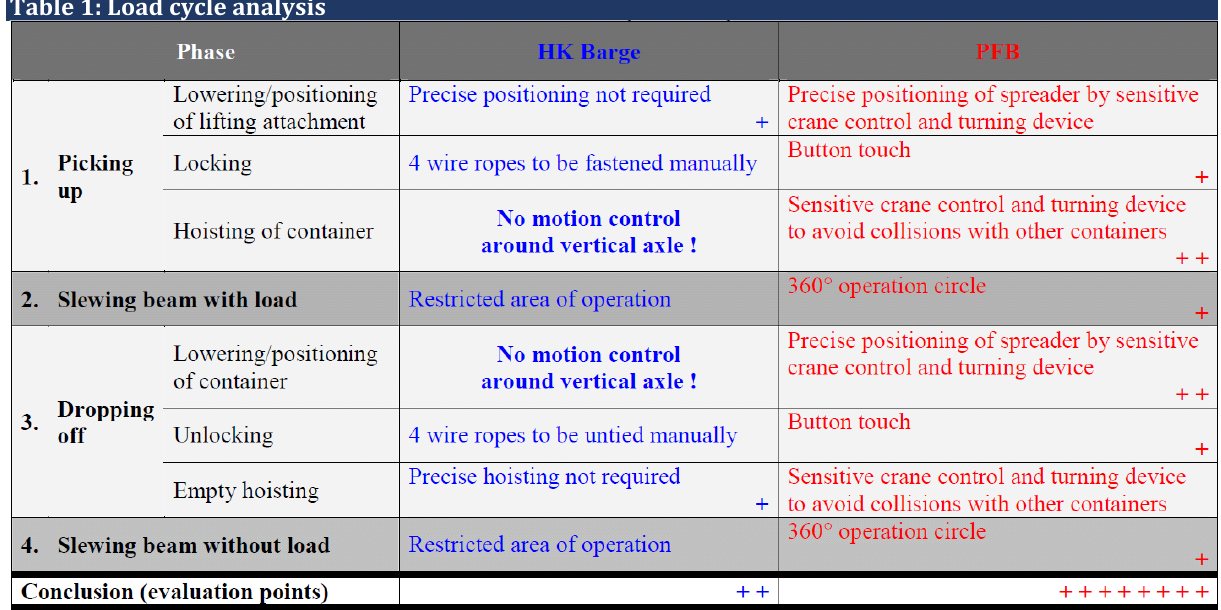
Table 1: Load cycle